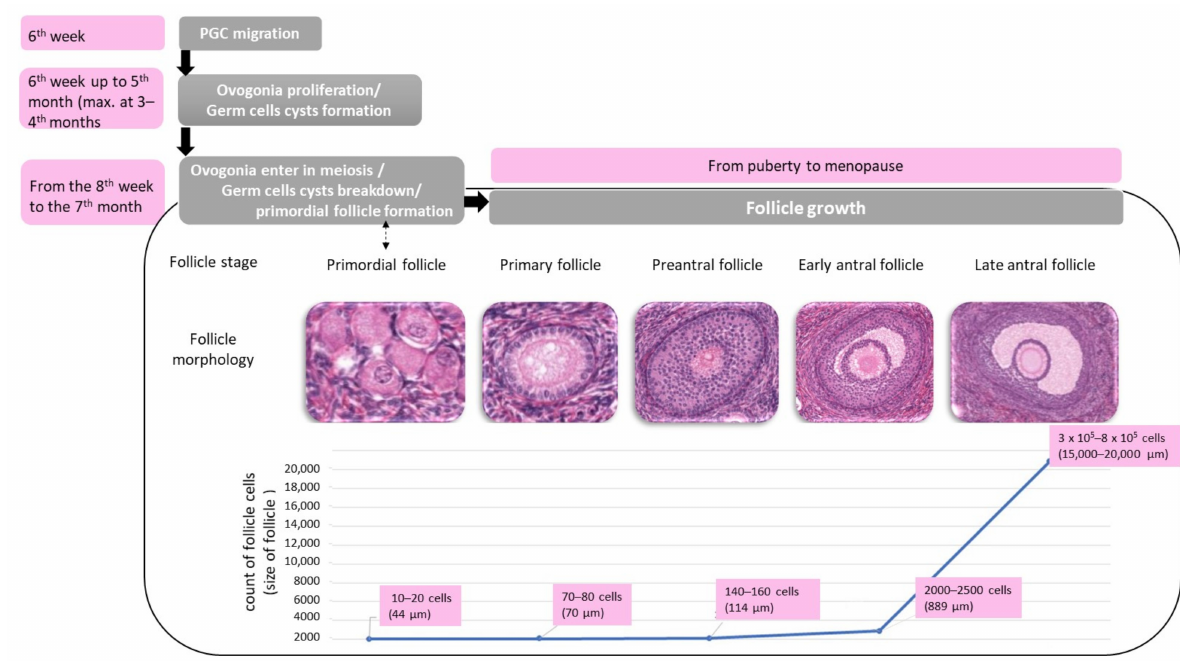
Figure 3. Human folliculogenesis and granulosa cells proliferation. The figure describes the different stages of follicle growth and the corresponding granulosa cell count and follicle size. Granulosa cells need to display a high proliferative potential to accommodate the tremendous proliferation needed during